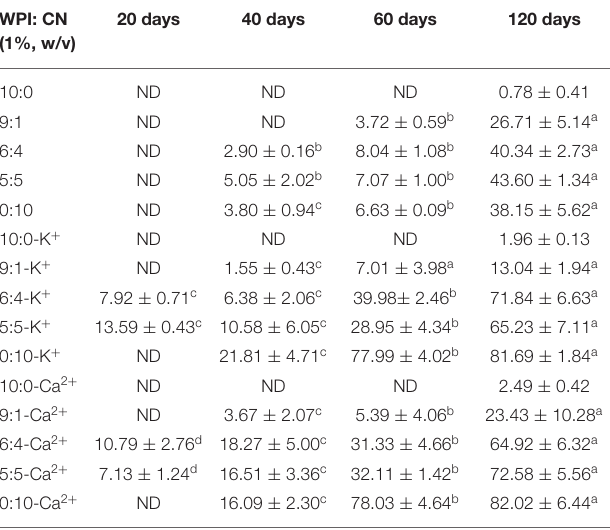
TABLE 1 | The creaming index of fresh 1,3-dioleoyl-2-palmitoylglycerol (OPO) emulsions (10% v/v OPO human milk fat substitutes and whey protein